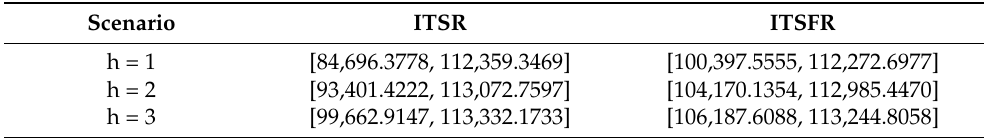
Table 1. Economic benefits of the Yinma River Basin under ITSR and ITSFR models (10 4 m 3 /yuan). Scenario